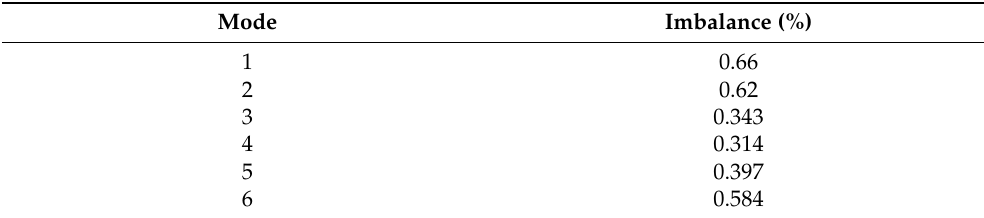
Table 4. Voltage Imbalance Between